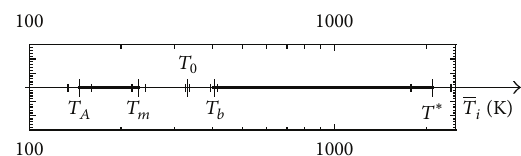
Figure 2: Classification of different mean temperatures ( 𝑇 𝑖 ) used in this statistical investigation. Great vertical bar shows average value and the small vertical bar shows delimitation of the Confidence Interval